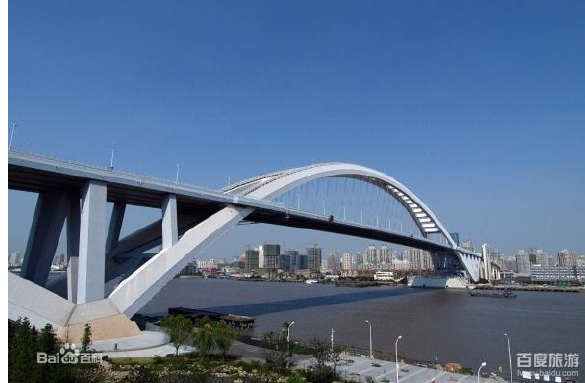
Figure 1.A perspective view onto the Lupu Bridge(©